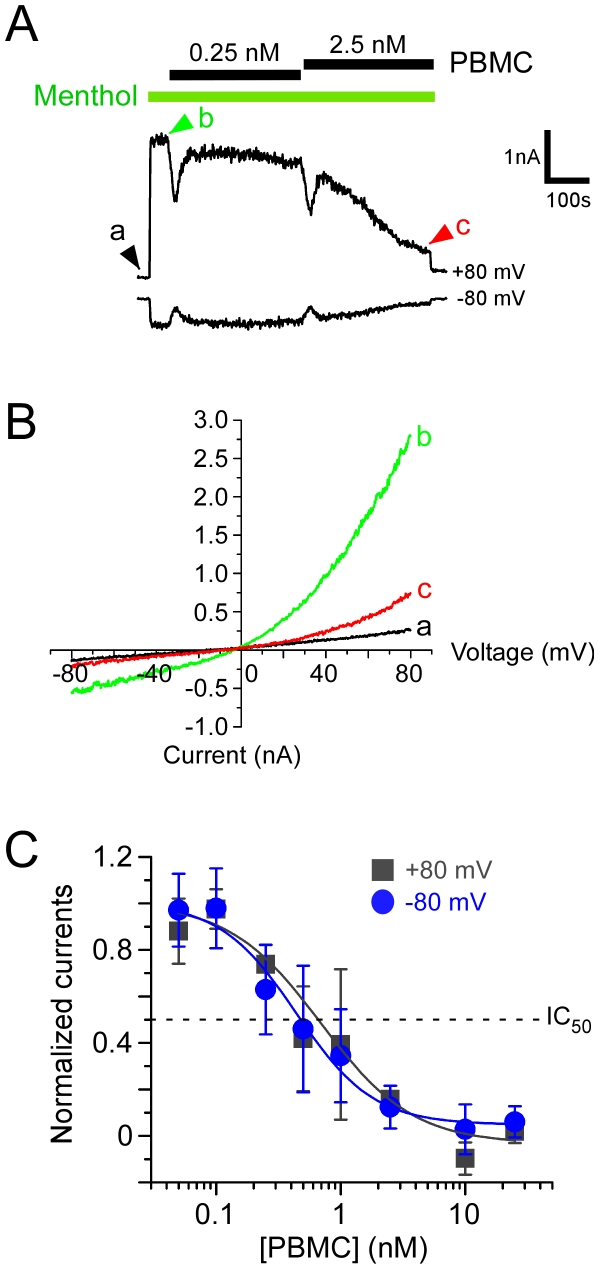
PBMC inhibits TRPM8 currents.
A) Representative whole-cell voltage clamp recording from a mTRPM8-expressing HEK293T cell. Currents, at both positive and negative potentials were measured during a voltage ramp from −80 mV to +80 mV (1 V/s) and evoked with 500 µM menthol (in the absence of extracellular calcium, with 10 mM EGTA in the pipette), followed by the addition of 0.25 nM then 2.5 nM PBMC for five minutes per concentration. Menthol was present in the perfusate for the duration of the drug application (green bars) and a perfusion artifact was inserted to demarcate the solution change. B) Current-voltage relationships at the time points indicated in A. C) Normalized currents plotted against a range of PBMC concentrations. Reduction of TRPM8 currents by PBMC was dose-dependent at +80 mV (squares) and −80 mV (circles). The calculated IC50 values were 0.6 nM and 0.4 nM at positive and negative voltages, respectively (n = 6–8 cells per data point).